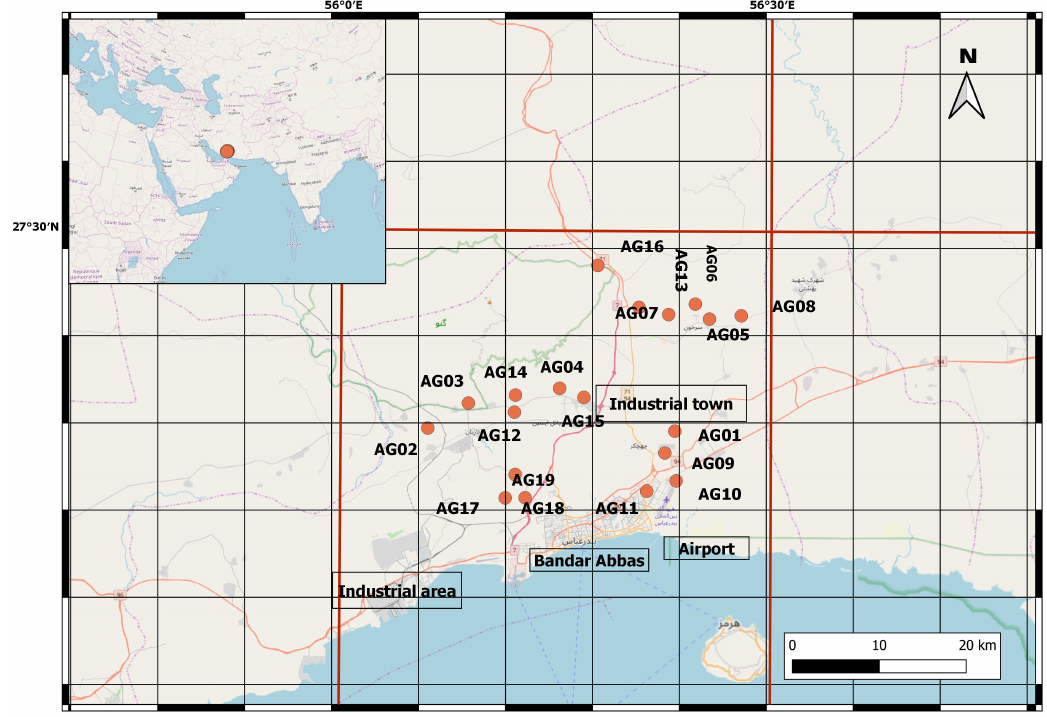
Figure 1. Study area and location of the sampling stations (orange dots).